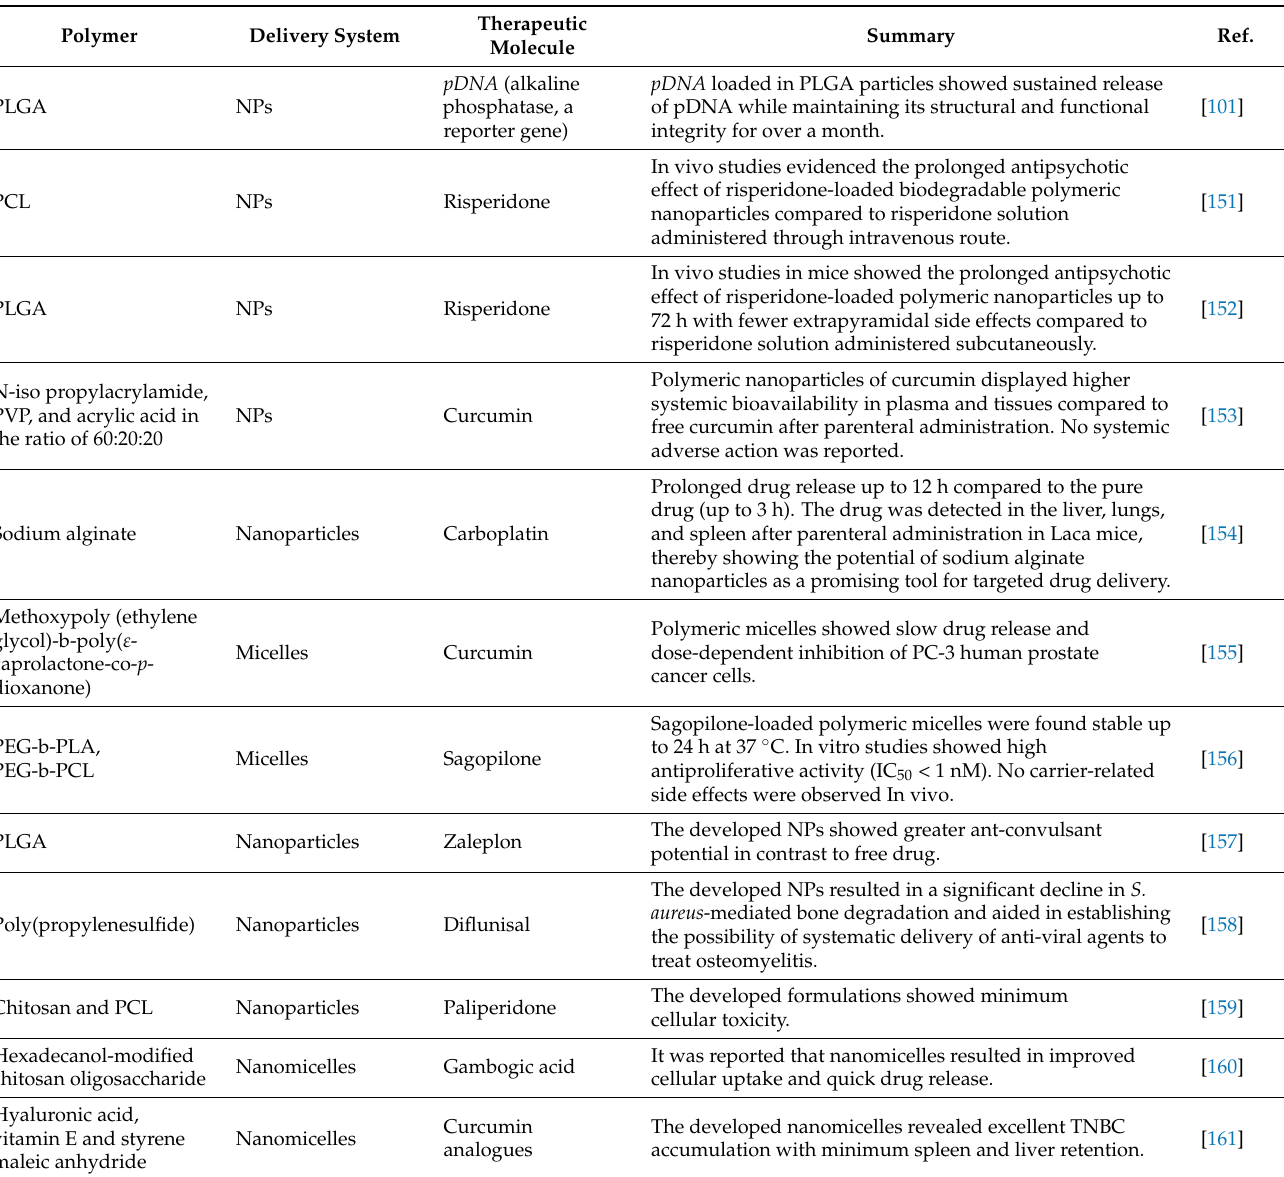
Table 4. A summary of reports on polymers employed as nanocarriers for parenteral delivery of drugs, peptides, and